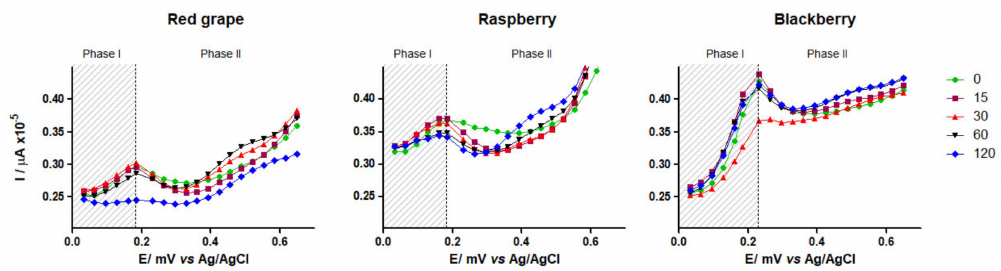
Figure 3. Di ff erential pulse voltammograms of post-digested berry samples, during their ex vivo apparent permeability and biotransformation. Polarization rate 5mV*s − 1 (abscissa values × 10 − 3